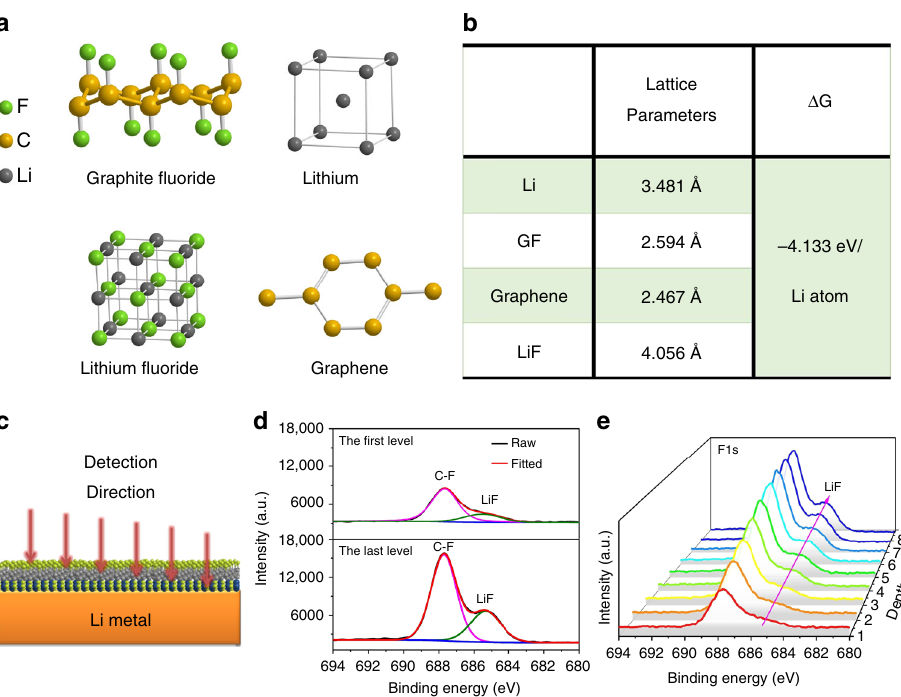
Fig. 2 DFT calculations and XPS spectra of GF – LiF layer. a Optimized structures of lithium, graphite fl uoride, lithium fl uoride, and graphene molecular models by DFT calculations, In the models, the fl uorine (F), carbon (C), and lithium (Li) atoms are displayed as spheres in green, yellow, and gray, respectively. b The lattice parameter of each modeling substrate. c The schematic diagram for the etching detection of Ar-ion sputtering. d High-resolution XPS F 1 s spectra of GF – LiF coating for the fi rst and last etching level. e XPS depth pro fi le of F 1